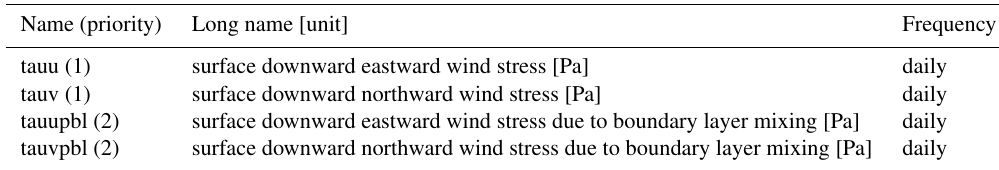
Table 4. Momentum (surface). 2-D variables (Grid: XYT).